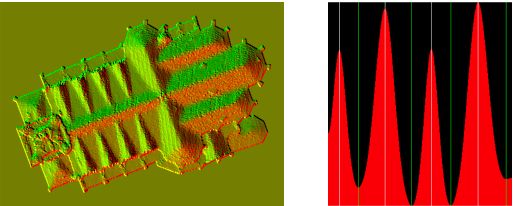
Figure 6: Left picture shows gradient directions computed from the height map. Partial derivatives are displayed as red and green values. The right picture shows a histogram of the gradient an- gles. The histogram is smoothed with a Gaussian filter. Detected maxima and threshold values for segmentation (which are the minima) are marked with